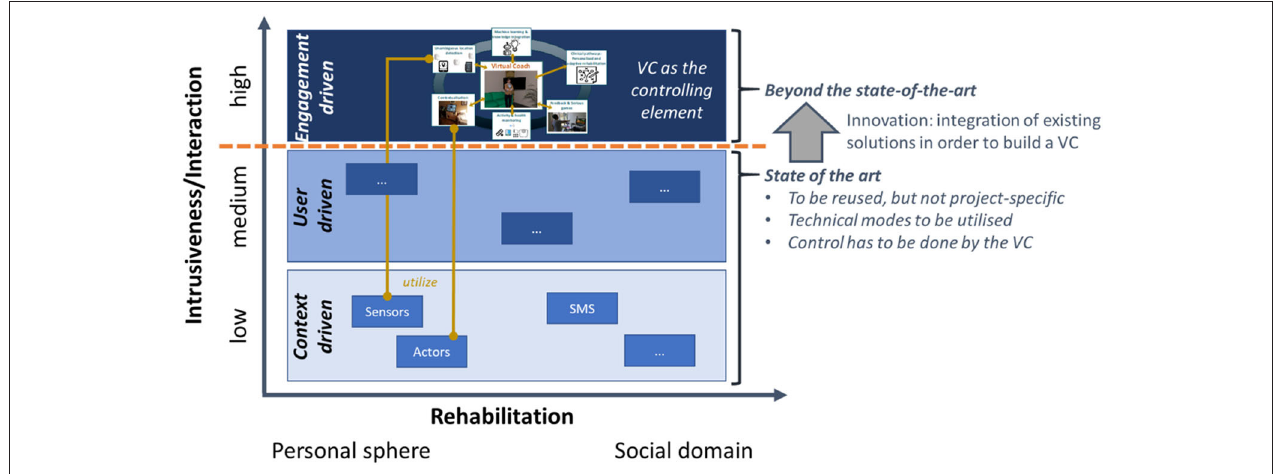
FIGURE 2 | Meaning of “beyond the state-of-the-art” —unique selling point of